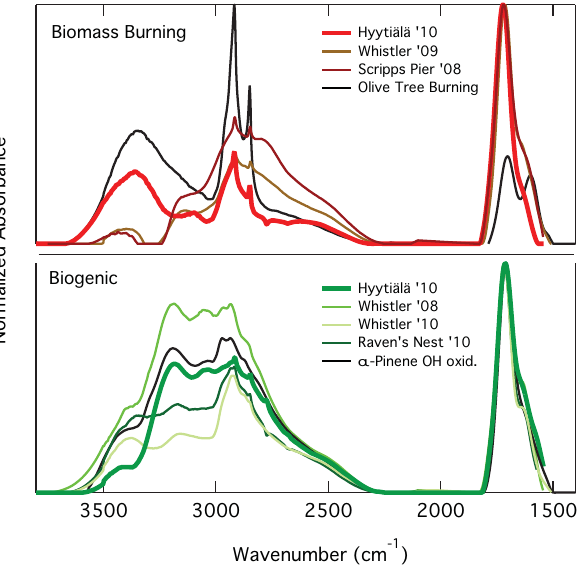
Fig. 6. Normalized biomass burning (top) and biogenic factors (bottom) from Whistler, Canada, and Scripps Pier (La Jolla, CA) (Schwartz et al., 2010; Takahama et al., 2011; Ahlm et al., 2012; Hawkins and Russell, 2010), in addition to SOA formed from aged olive tree burning emissions (Kostenidou et al., 2013) and SOA products from smog chamber oxidation of α -pinene (OH) (Chhabra et al.,